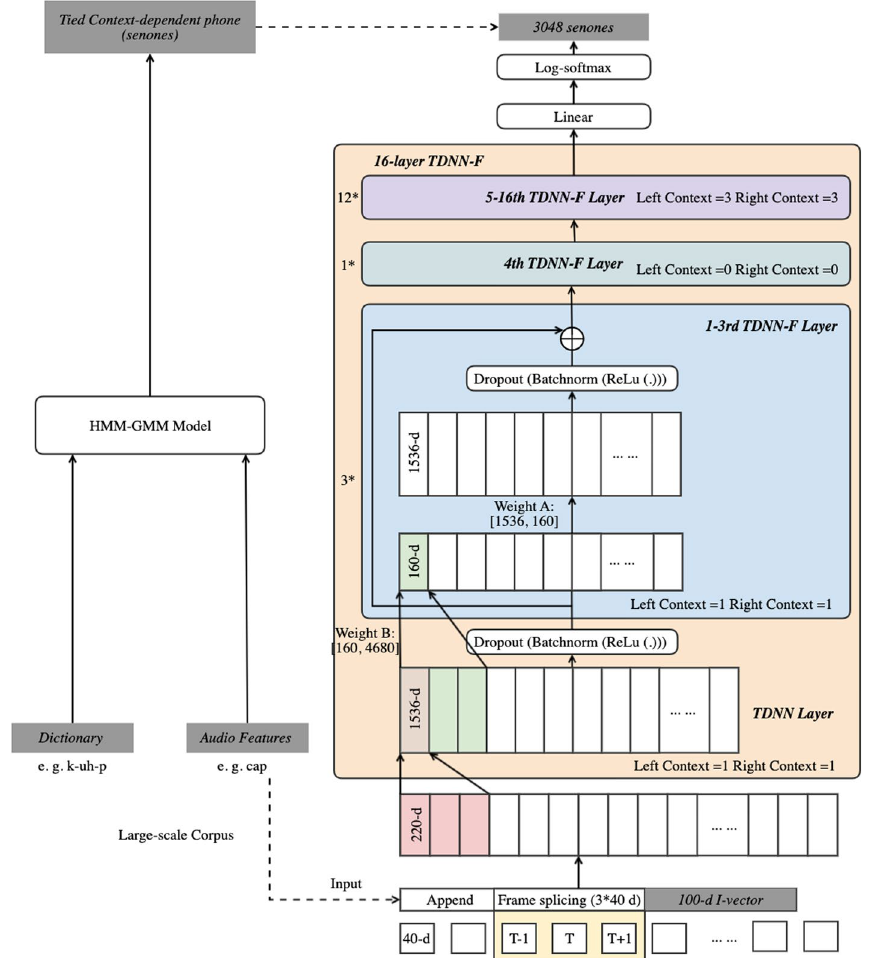
Fig. 3 The structure of the TDNN-based acoustic